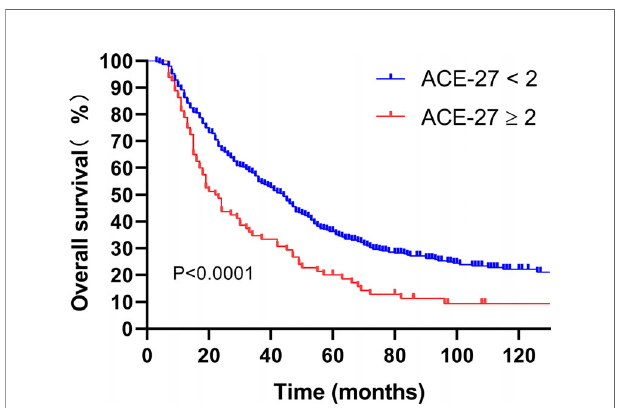
FIGURE 1 | Kaplan-Meier analysis of overall survival is strati fi ed by ACE-27. ACE-27, Adult Comorbidity